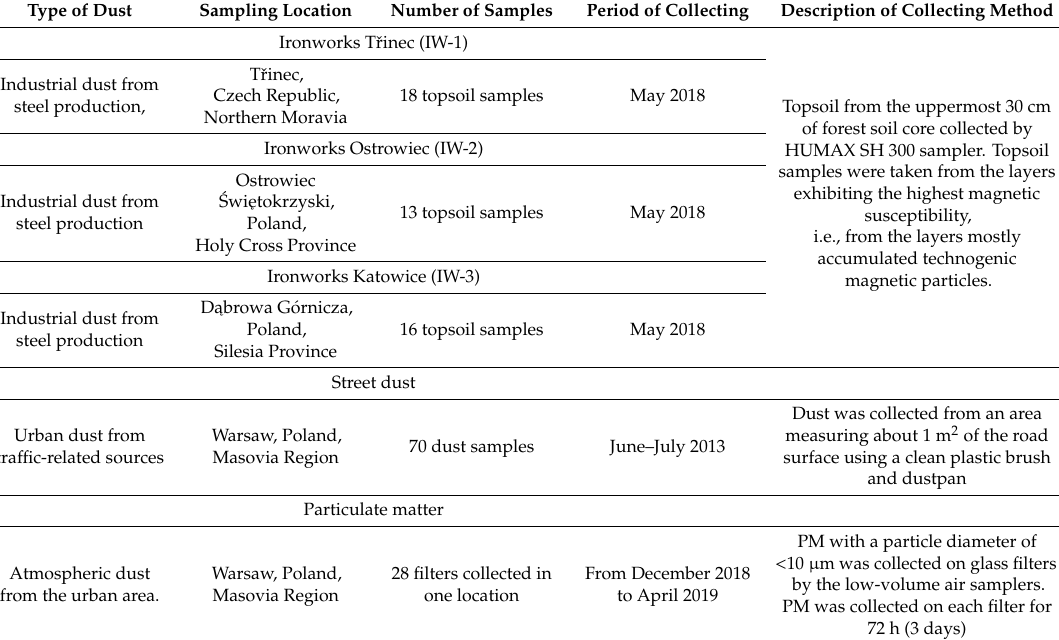
Table 1. Details of the subsoil types and dust samples, time period, location and sample collection